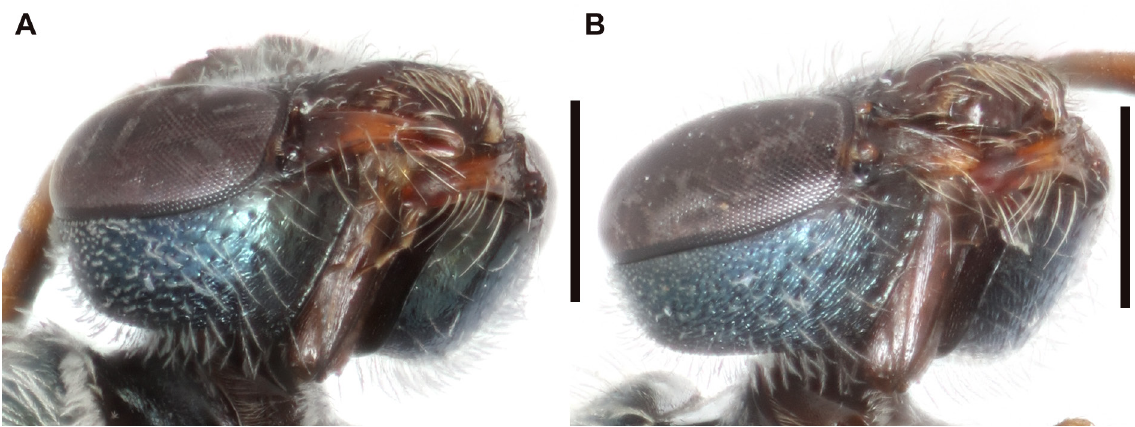
Fig. 82. Ventral surface of head showing postgena. A . Lasioglossum profundum sp. nov., ♀, smooth and shiny. B . L. coactus (Cresson, 1872), ♀, dull and lineolate. Scale bars = 0.5